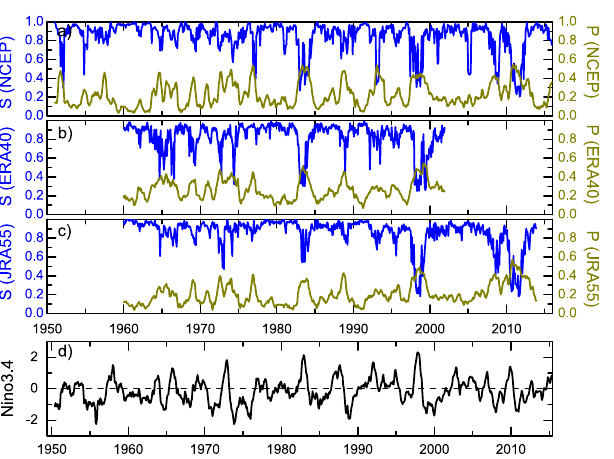
Figure 2. Temporal variation of the percentage of isolated nodes P , giant component size S , as well as the Niño3.4 index. ( a – c ) are the results calculated from the three different reanalysis datasets: ( a ) NCEP, ( b ) ERA40, and ( c ) JRA55. The yellow lines represent the percentage of isolated nodes P (refer to the right-hand axis), while the blue lines show the giant component size S (refer to the left-hand axis). ( d ) Shows the Niño3.4 index downloaded from NOAA. The x-axis in ( d ) was shifted to the right by half a year, because the P and S values were calculated using data one year before the marked time point t (see “Method” subsection of “Data, Model, and Methods”). As is clearly seen, all the three reanalysis datasets provide identical results. When the Niño3.4 index was larger/smaller than + 0.5/ − 0.5, higher (lower) P ( S ) values were